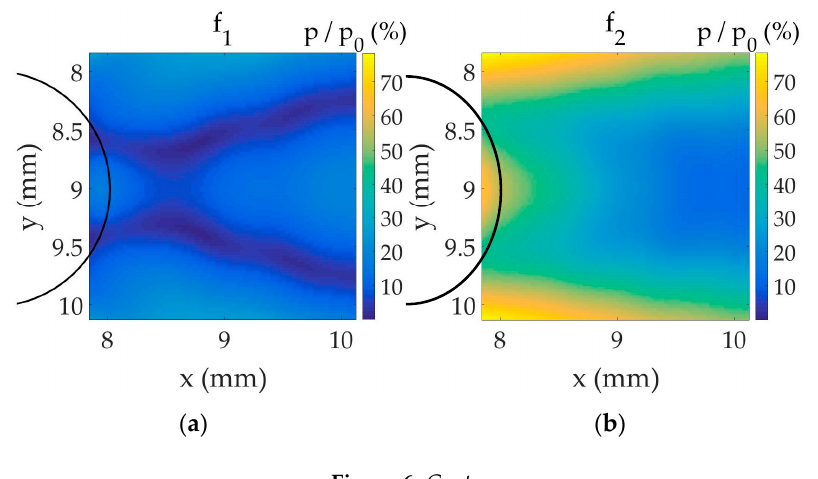
Figure 5. Schematic representation of the two-dimensional problem in which the red square represents the output signal area displayed in Figure 6.